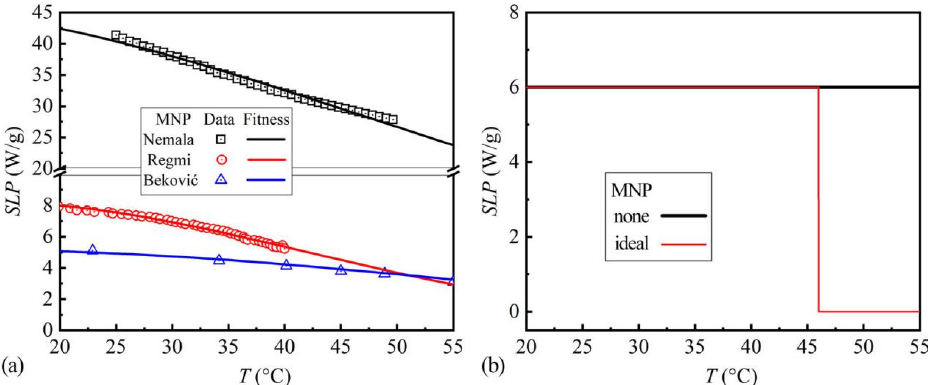
Figure 4. ( a ) The SLP data and fitted SLP - T curves of MNP Nemala , MNP Regmi , and MNP Bekovi ć ; the SLP